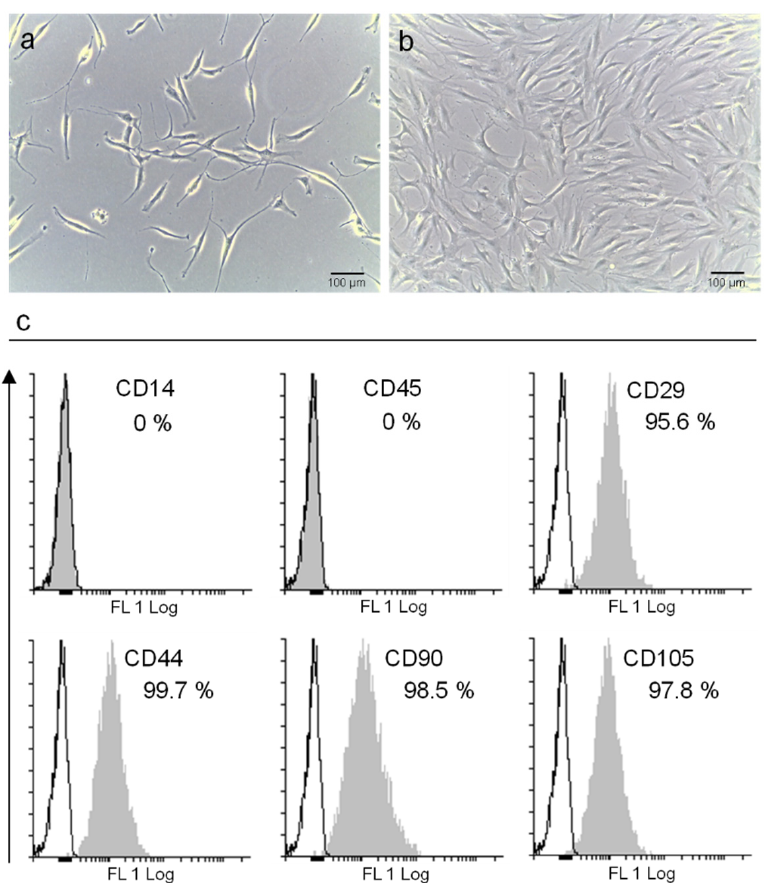
Figure 1. Characterization of Ad-MSC cultures. Morphological analysis by optical microscopy of Ad-MSCs at passage 3, in ( a ) sub-confluence and ( b ) confluence conditions (Scale bar: 100 µm). ( c ) Cytometric evaluation of Ad-MSC immunophenotype. Data are presented as percentage of positive cells (gray profile) in comparison with the isotype control (white